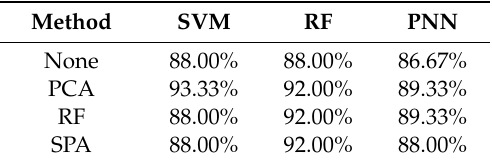
Table 3. Comparison of identification accuracies for the support vector machine (SVM), RF, and the probabilistic neural network (PNN).